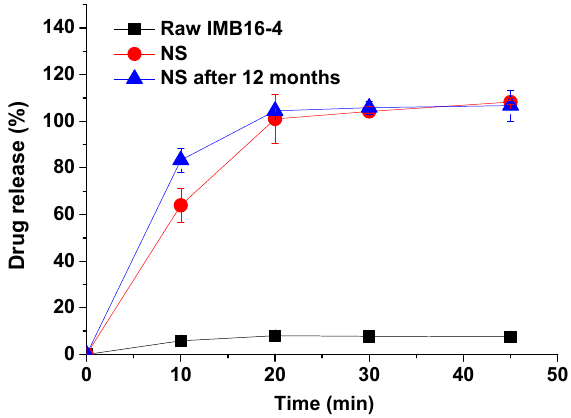
Figure 4. Release profiles of pure IMB16-4 and NS in pH 1.0 containing 3% SDS dissolution medium. Each data point represents the mean ± SD of three determinations.